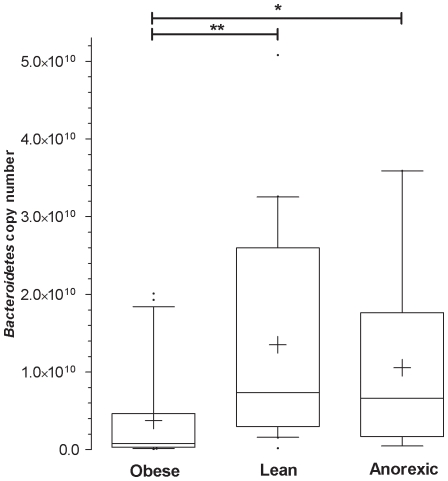
The Bacteroidetes quantification.Box and whisker: 10–90 percentiles. Outliers are plotted as a black bubble, means are plotted as a plus, and medians are the black lines in the boxes. P value <0.05 is represented as * and P value <0.01 is represented as ** on the graph.